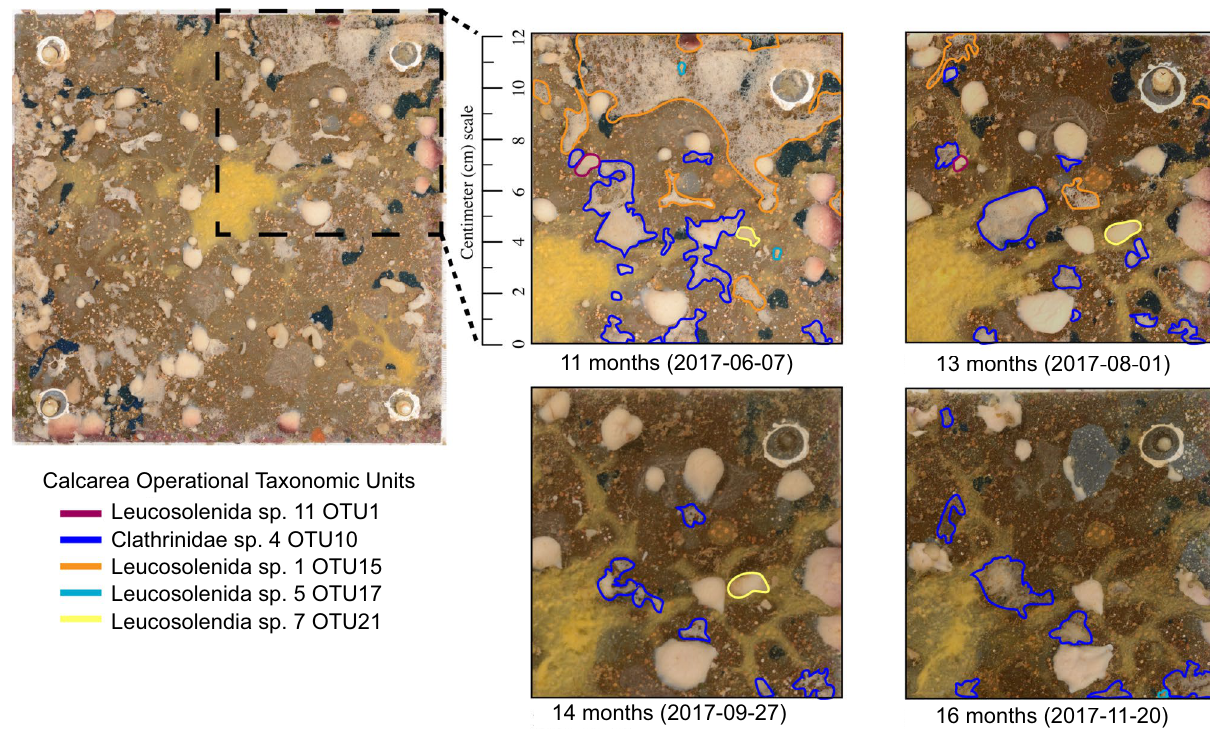
Figure 5. Recruitment of calcareous OTUs from a subsection of a mesocosm ARMS plate through four time points capturing a decrease in diversity and abundance of Calcarea from 2017-06-07 (11 months) through 2017- 11-20 (16